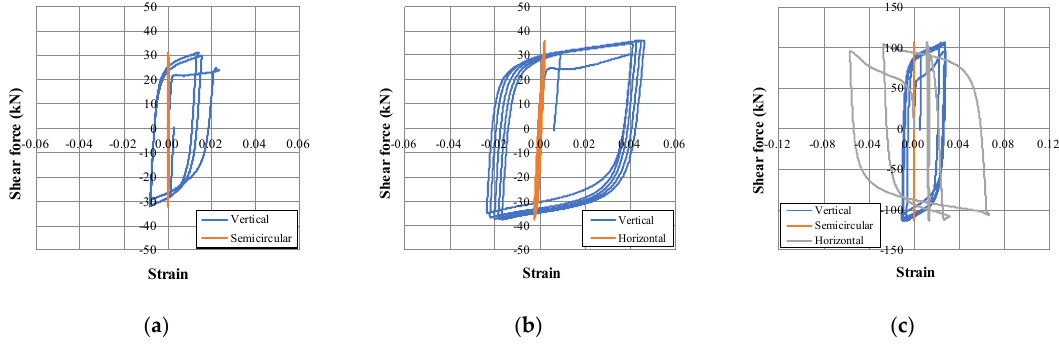
Figure 6. Strain distributions of tested specimens: ( a ) SD1; ( b ) SD2; ( c ) SD3.